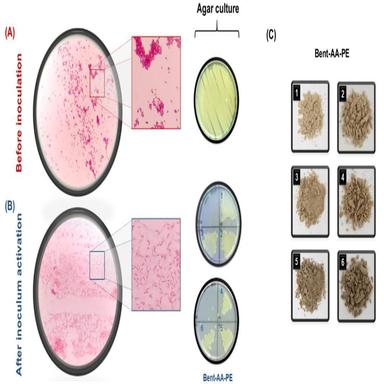
Digital photographs of Gram test and agar growth medium of Azotobacter chroococcum before inoculation (A) and after the reactivation of the inoculum (B), as well as, corresponding photographs of Bent-AA-PE composites (C).